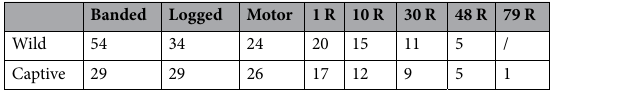
Table 1. Number of birds completing each step of the experiment: individually identified, logged on the apparatus, passing motor learning task and completing at least 1, 10, 30, 48 or 79 reversals. Note that in the wild the program only allowed birds to perform up to 48